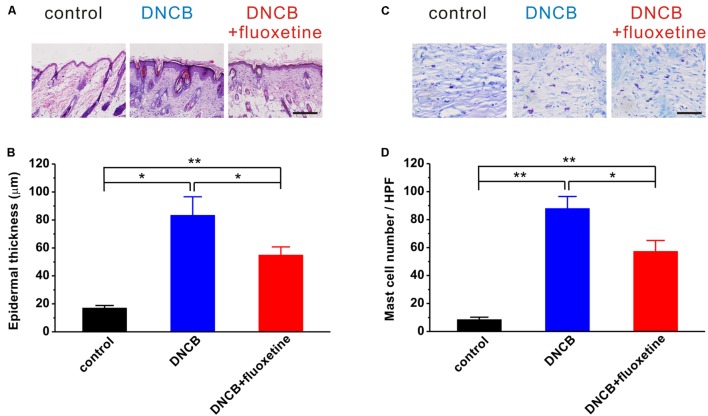
Histopathological findings showing the preventive effect of chronic fluoxetine treatment on DNCB-induced AD-like skin lesions.
(A) Skin sections (4 μm thick) were stained with H&E. Scale bar is 100 μm. (B) Epidermal thickness was analyzed in the H&E-stained sections. (C) Skin sections were stained with toluidine blue. Scale bar is 50 μm. (D) The number of mast cells were counted in five high-power fields (HPF) chosen at random in each toluidine blue-stained slide by three different pathologists. n = 10 for control and DNCB, n = 14 for DNCB+fluoxetine. ∗P < 0.05, ∗∗P < 0.01.